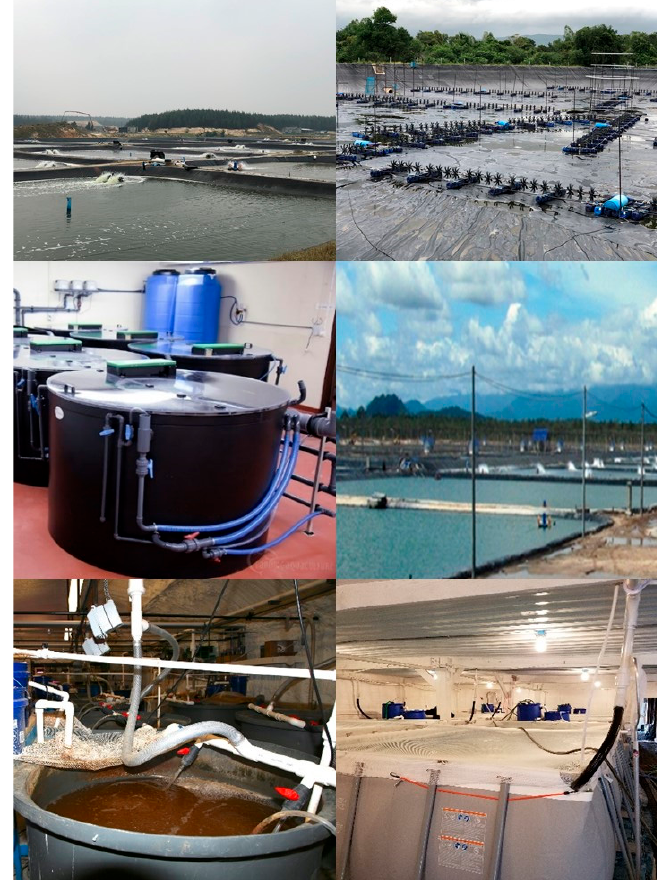
Figure 4. Super-intensive commercial shrimp production using flow-throw water in China and Thailand [28] (upper), pilot-scale indoor RAS used for L. vannamei nursery in Europe ([Source: C. Espinal and [82]) and outdoor RAS in a commercial shrimp farm, Malaysia [80] (middle); hybrid BioRAS at Lab-scale and commercial indoor farm, U.S. (bottom) (courtesy: A. Ray).